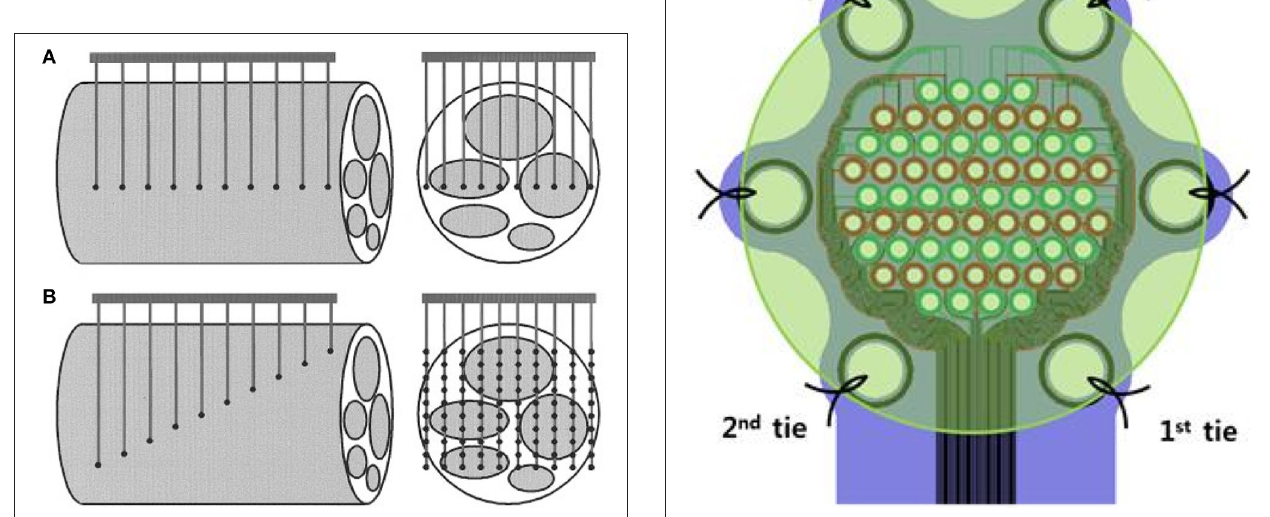
FIGURE 5 | Comparison of the Utah Electrode Array (A) and the Utah Slanted Electrode Array (B) . Reproduced with permission from Branner et al. (2001).